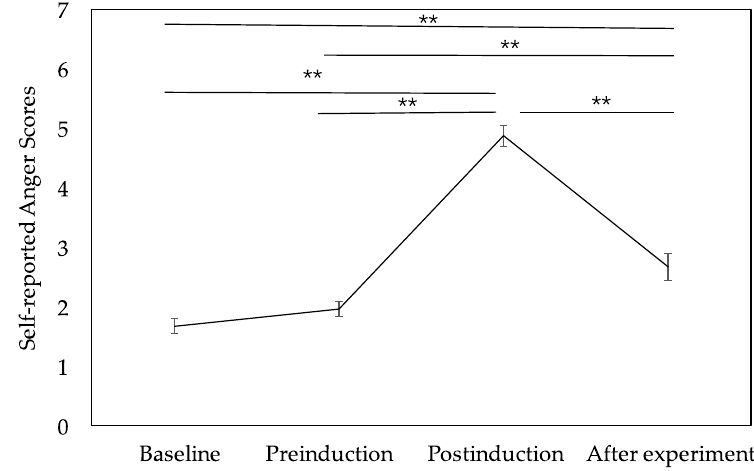
Figure 2. Self-reported anger scores across the four states (baseline, preinduction, postinduction, and after experiment). Error bars indicate the standard error of the mean. * p < 0.05, ** p < 0.01.